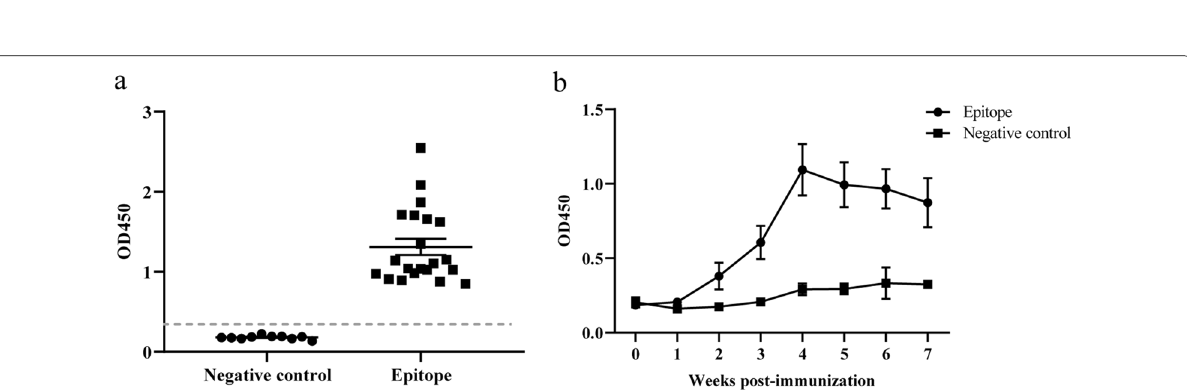
Fig. 6 Reactivity of the epitope with chicken serum samples. The immunogenicity of the identified epitope was investigated using serum samples from FAdV-4 infected chickens ( a ) and inactivated FAdV-4 immunized chickens ( b ). The cut-off was set as 2.1 times the mean OD 450 value of the ten healthy chicken serum